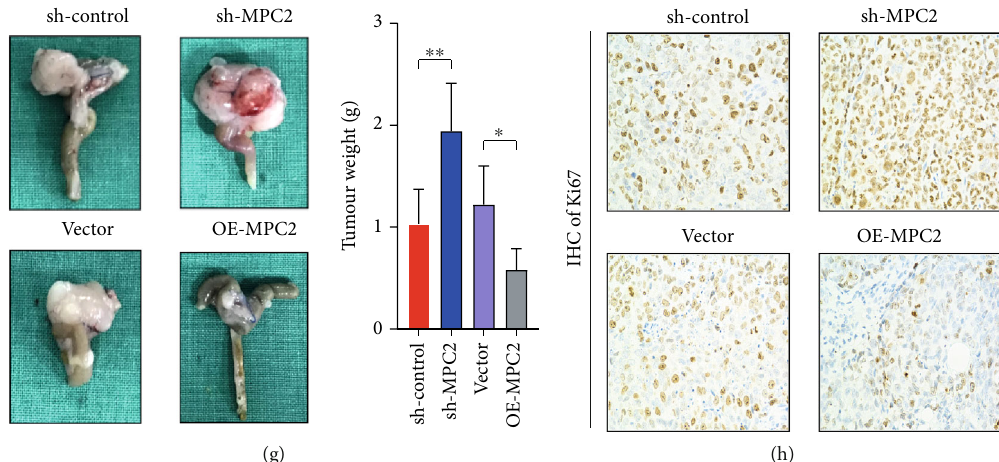
Figure 2: MPC2 suppressed CRC growth in vitro and in vivo . (a) The protein expression of MPC2 in seven CRC cell lines was detected using western blotting. (b) The inhibition e ffi ciency in RKO cells (right) and HCT116 cells (left) using western blotting. (c) The inhibition e ffi ciency in HCT116 (left) and RKO (right) cells showed by qRT-PCR (relative to shNC). (d) The viability of HCT116 (left) as well as RKO cell (right) transfected with shMPC2 or shNC detected with CCK-8 assay. (e) Colony formation ability of HCT116 and RKO cells through transfection by shNC or sh-MPC2. (f) Representative bioluminescence images of mice orthotopically injected with mcherry and luciferase-expressing HCT116 cells transfected with shNC and shMPC2 as well as vector and OE-MPC2. (g) The representative images in gross and weight of tumor mass from orthotopic mouse model among shNC, sh-MPC2, vector, and OE-MPC2 groups (Student ’ s t -test). (h) Ki67 ’ s expression in the orthotopic tumor tissues (shNC, sh-MPC2, vector, and OE-MPC2, n = 5 ). ∗ p < 0 : 05 , ∗∗ p < 0 : 01 , ∗∗∗ p < 0 : 001 , and ∗∗∗∗ p < 0 : 0001